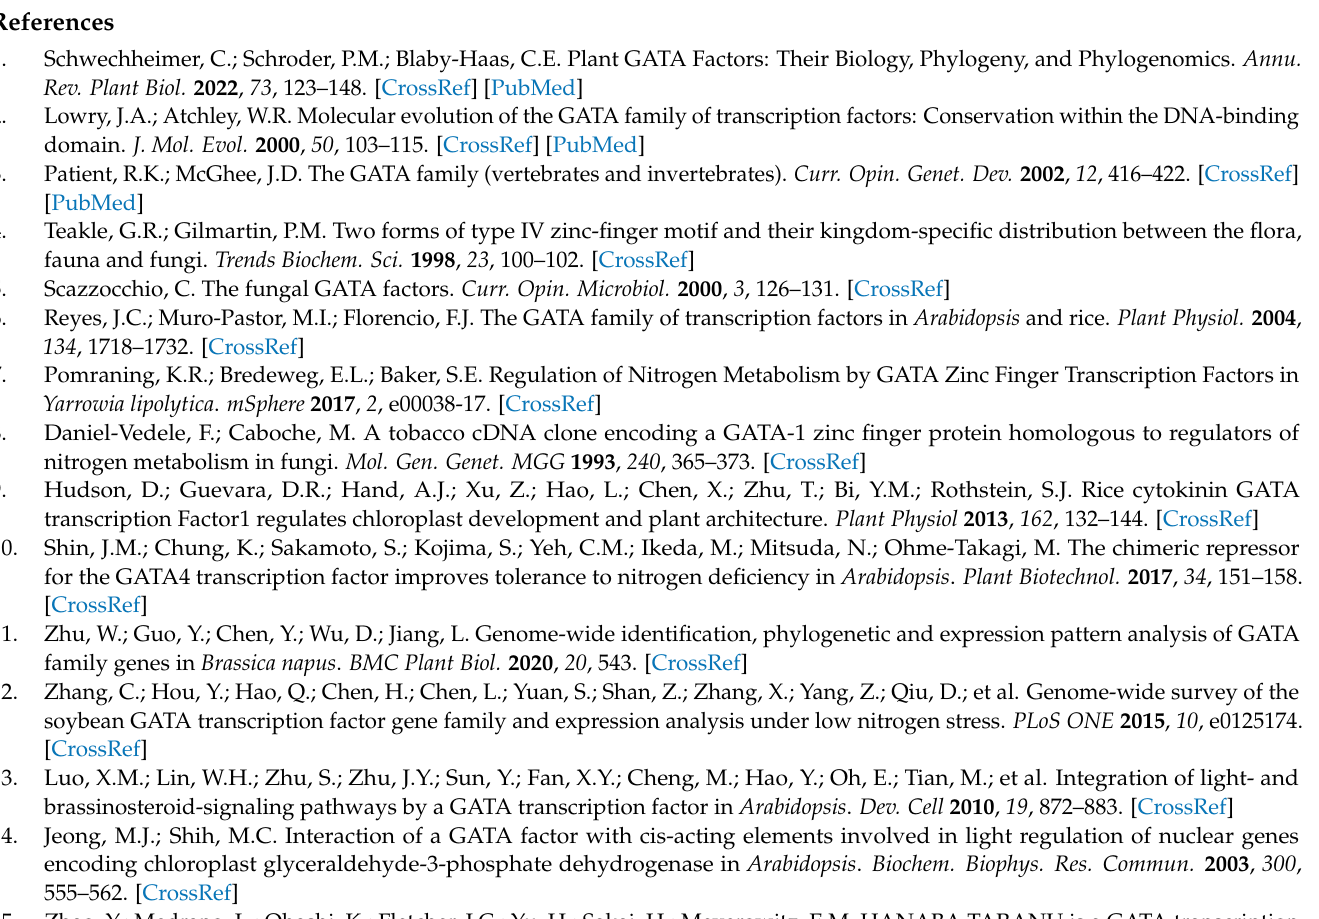
Table S2. DNA binding sites identified for GATA factors of 8 nitrogen metabolism-related genes in the cultivated genome by